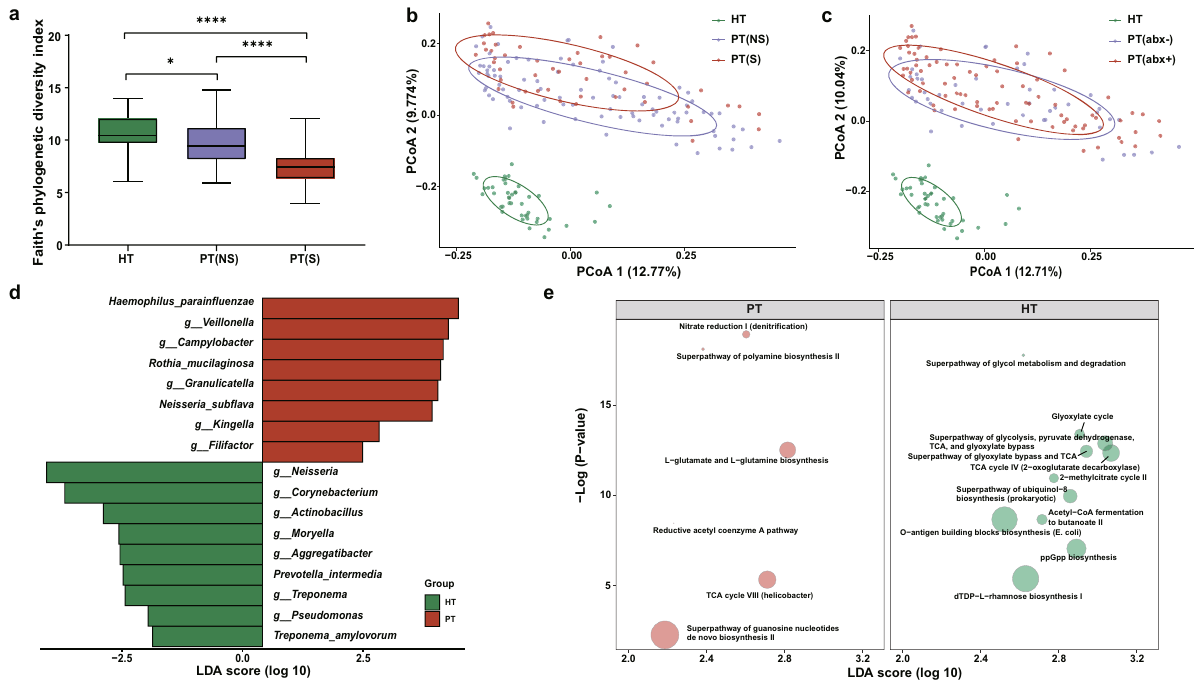
Fig. 2 Altered oral microbiota in COVID-19 patients. a Species diversity differences among the HT ( n = 44), PT(NS) ( n = 90), and PT(S) ( n = 50) groups were estimated by Faith ’ s phylogenetic diversity index. * p < 0.05, **** p < 0.0001. p -values were obtained using one-way ANOVA followed by Tukey ’ s multiple comparisons test. The line in the middle of the box, bound of the box and whiskers represent the median, 25th – 75th percentiles, and min-to-max values, respectively. PT(NS), throat swab samples from the non-severe patients group; PT(S), throat swab samples from the severe patients group. b PCoA plot based on unweighted UniFrac distances showing microbial structural clustering among the HT, PT(NS), and PT(S) groups. Ellipses represent 68% con fi dence intervals. c PCoA plot according to unweighted UniFrac distances displaying bacterial structural discrimination among the HT ( n = 44), PT(abx − ) ( n = 49), and PT(abx + ) ( n = 91) groups. Ellipses represent 68% con fi dence intervals. PT(abx − ), throat swab samples from patients without antibiotic interference; PT(abx + ), throat swab samples from patients with antibiotic interference. d Bacterial taxa identi fi ed a signi fi cant difference between HT ( n = 44) and PT ( n = 140) groups by LEfSe. Seventeen taxa were validated using MaAsLin2 adjusting for covariates. PT throat swab samples from patients, LDA linear discriminant analysis. e Differentially abundant MetaCyc pathways identi fi ed with the functional analysis result of metagenomes. Only the pathways identi fi ed by both LEfSe and MaAsLin2 were presented. Circle size represents the relative abundance of